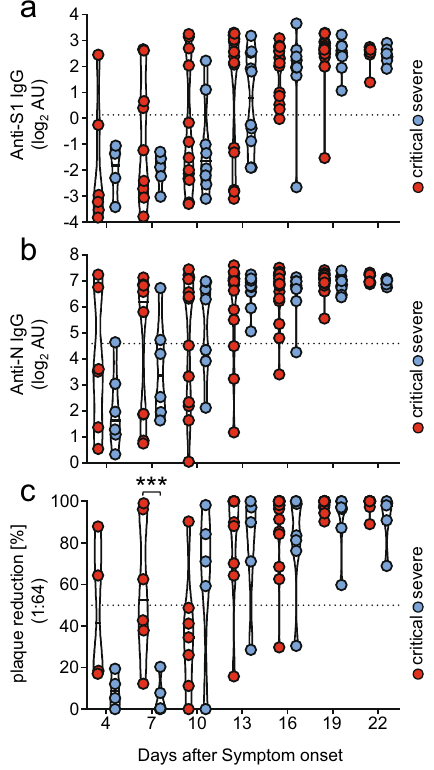
Fig. 1 | Antibody responses against SARS-CoV-2 across severe versus critical clinicalcourseofdisease. IgGantibodylevelswereanalyzedinlongitudinalserum samples from hospitalized SARS-CoV-2 infected individuals. Patients were cate- gorized as critically diseased when in need of invasive mechanical ventilation ( n =27; red symbols) compared to severely diseased patients who did not require invasive ventilation ( n =14; blue symbols). Each dot represents the mean value obtained by the analysis of all samples, which were available at the indicated time points (+/ − 1 day) following symptom onset. a IgG response against SARS-CoV-2 S1 – protein and b SARS-CoV-2 N-protein as determined by commercial ELISA assays. Dotted lines represent cut-off values for commercial S1- and N- speci fi c ELISA assays. Each dotrepresents the meanvalue obtained by the analysis of allsamples, which were available at the indicated time points (+/ − 1 day) following symptom onset. c Serum neutralization capacity against SARS-CoV-2 measured by a plaque reduction assay. Sera were considered neutralizing at 50% plaque reduction (dot- ted line) at a 1:64 dilution. Solid black lines indicate the median. Signi fi cant dif- ferences were tested using a linear mixed effects model (one-sided, no adjustments) ( *** p <0.001). Source data are provided as a Source Data fi